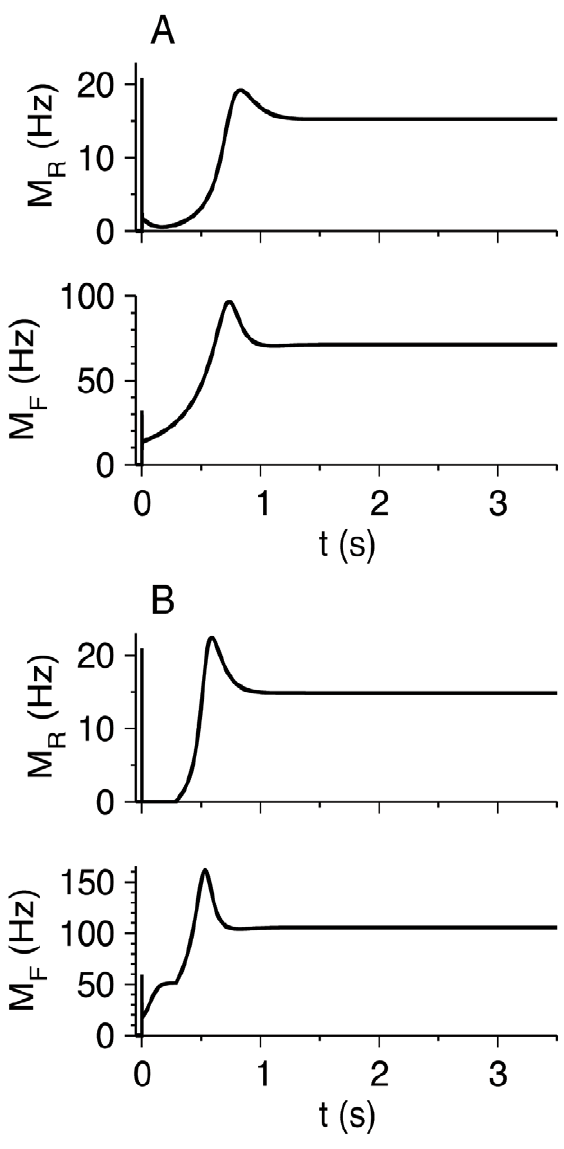
Figure 8. Response of the RS-FS network to step inputs I R H ( t ) and I F H ( t ) to the RS and FS neurons. Time courses of M R (top panel) and M F (bottom panel) are shown. Parameters: g RR =20, g FR =25, g RF =50, g FF =5, I R =0.29. (A) I F =0.35. (B) I F =0.45. values of I R and I F , both populations of interneurons are active ( M L . 0, M F . 0). Between the last three regimes ( M F = 0, M L = 0, and M L . 0, M F . 0), there is a state of slow oscillations, on the time scale of short-term synaptic plasticity (see below). This phase diagram remains qualitatively the same if the synaptic conduc- tances are varied, except that fast oscillations, like those shown in Figure S4C, are observed for large g RR (not shown).